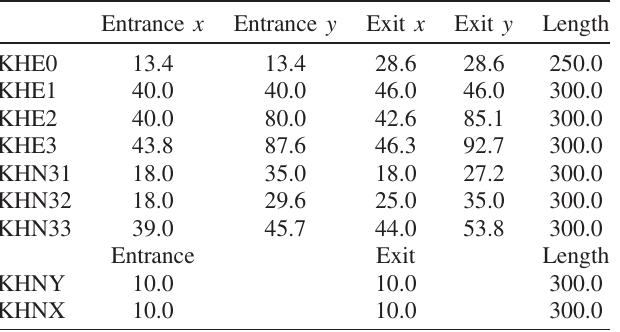
TABLE I. Half apertures and length of the collimators in mm. KHE0 and KHE1 are circular, KHE2 and KHE3 elliptical collimators. KHNX and KHNY are tflat slits.